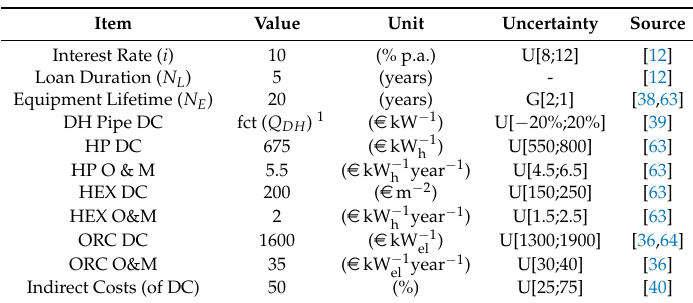
Table 4. Summary of the model parameters for investment costs and their distribution in the input uncertainty space for the evaluation of the case studies (uniform U[lower;upper]; gamma